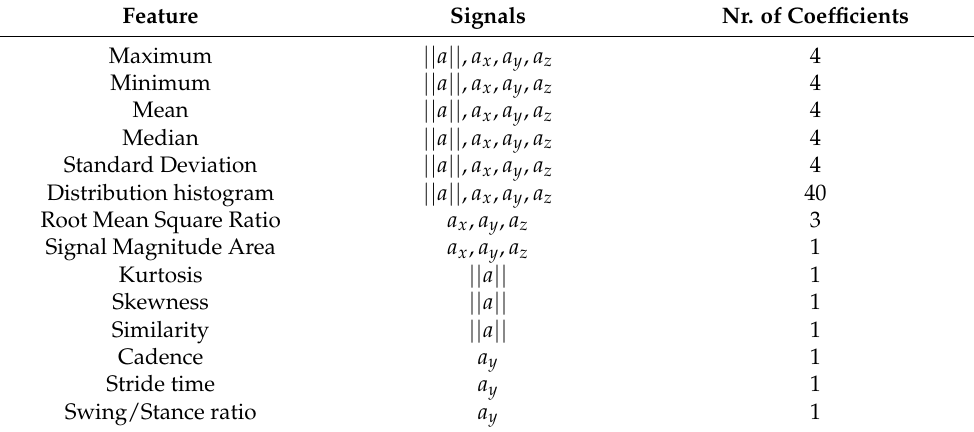
Table 2. Time-domain